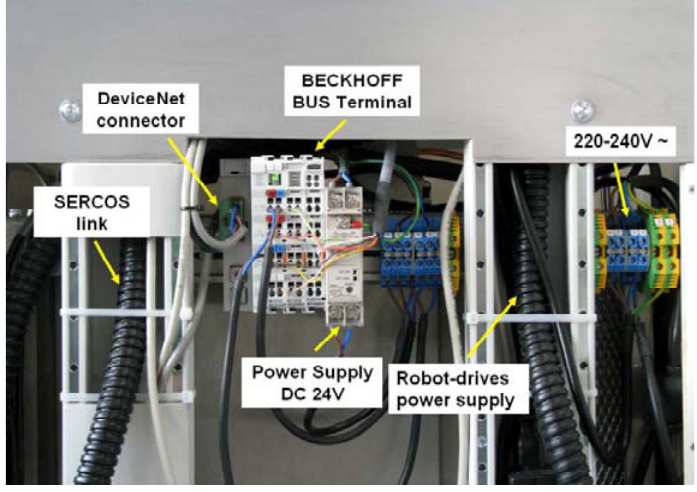
Figure 9. Inner connections of the robotic system, including a DeviceNet bus terminal and power supply.